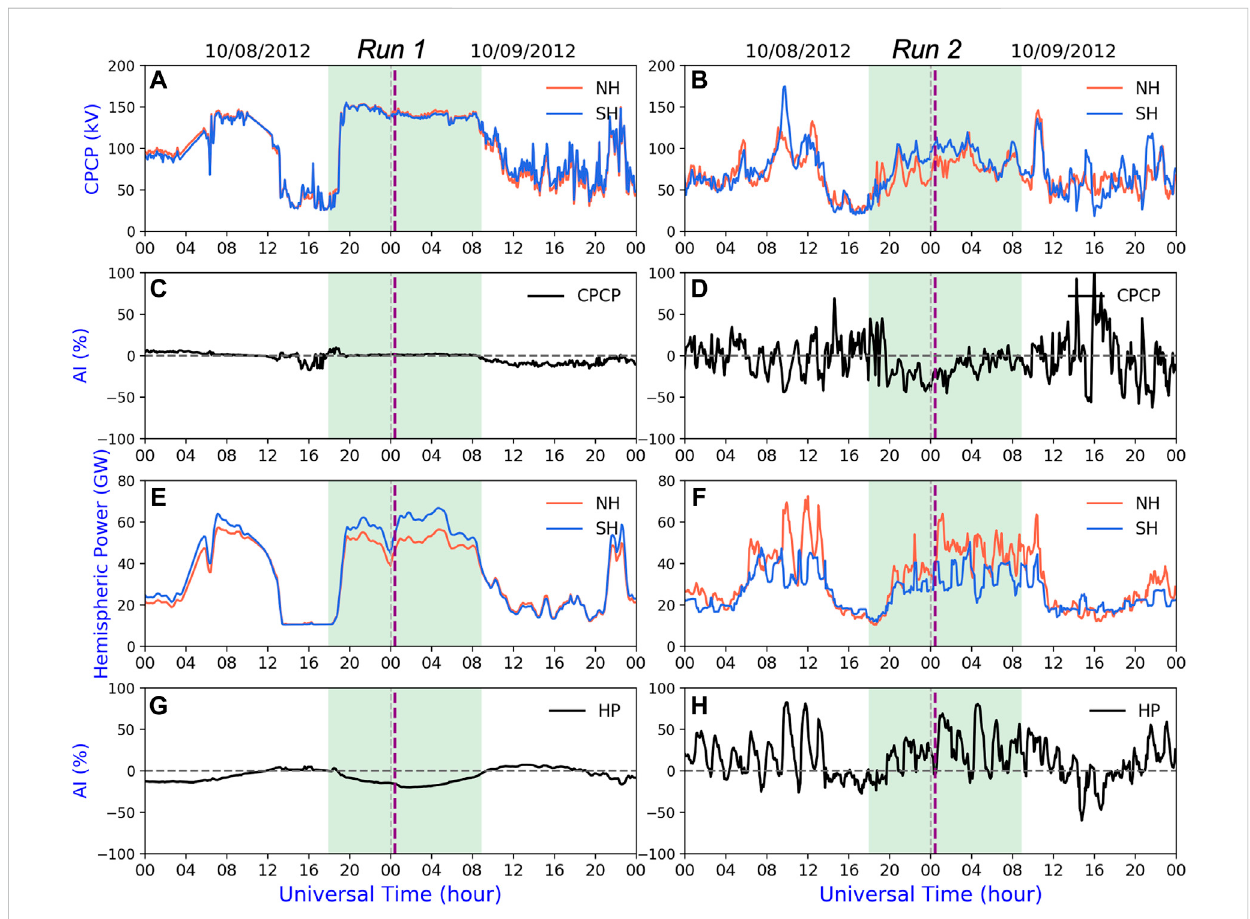
FIGURE 6 Inter-hemispheric comparisons of the (A, B) cross-polar-cap potential (CPCP) and (E, F) hemispheric power (HP) and their corresponding asymmetry index (AI) during the October 8 – 9, 2012, geomagnetic storm: (C, D) for CPCP and (G, H) for HP. The left column is for run 1 (driven by empirical models) and the right is for run 2 (driven by data-based realistic patterns). The vertical purple dashed line marks the IMF B y reversal time during the storm main